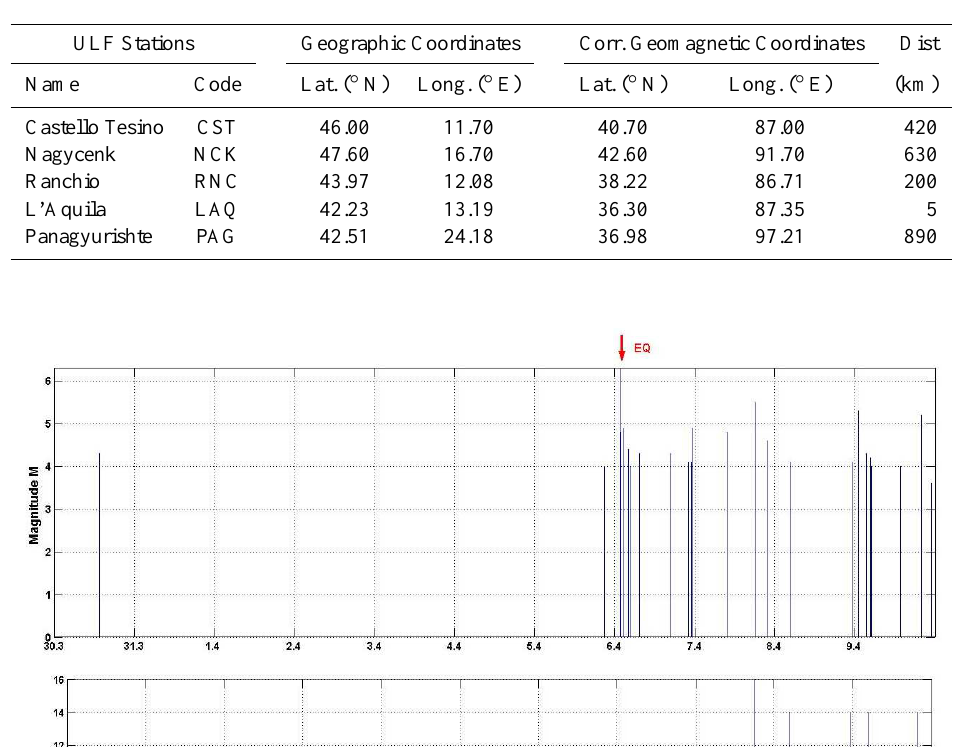
Table 1. SEGMA ULF chain and distances to L’Aquila erathquake.